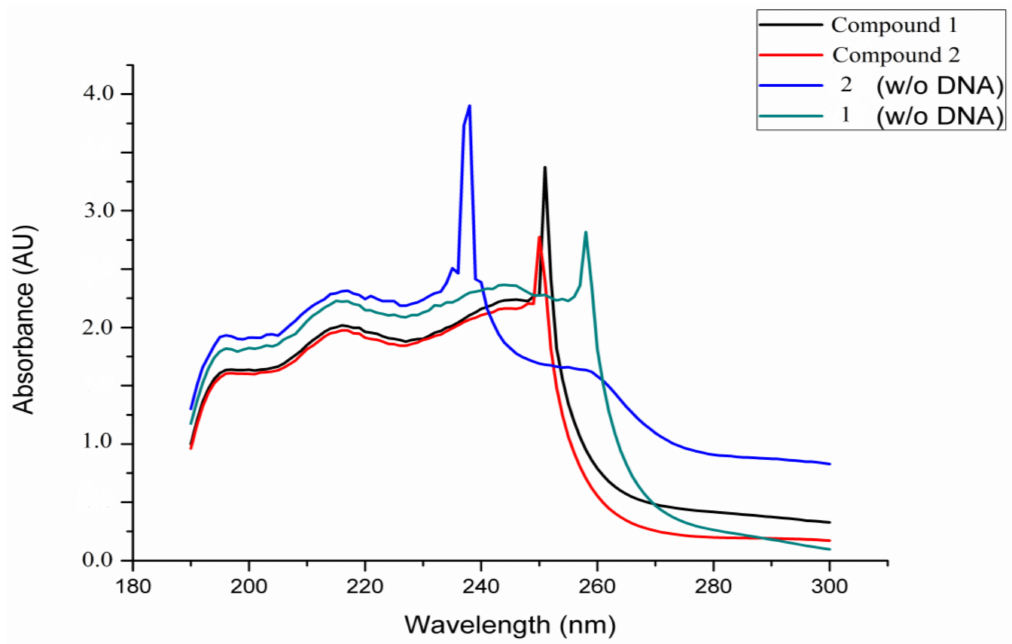
Figure 5. Compound 1 showed hyperchromism (blue shift), while compound 2 presented a hypochromism (red shift) after treatment with Leishmania tropica DNA.